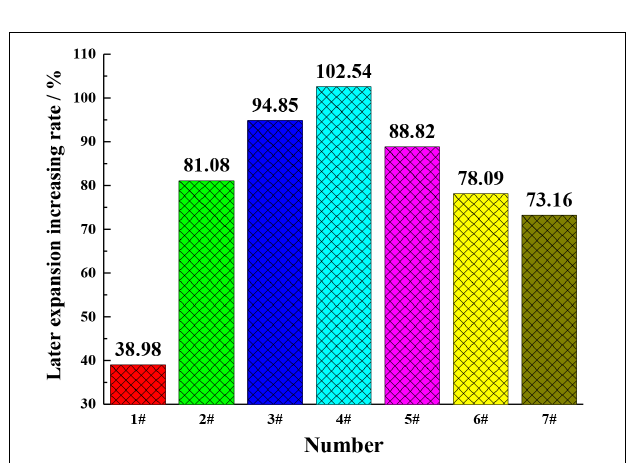
FIGURE 6 | Later expansion increasing rate of the cement with different MgO